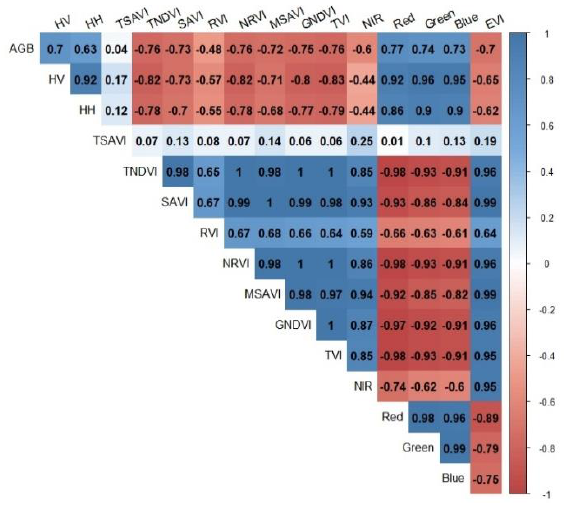
Figure 2. Pearson’s correlation coefficient (R) between aboveground biomass and different remotely sensed parameters.